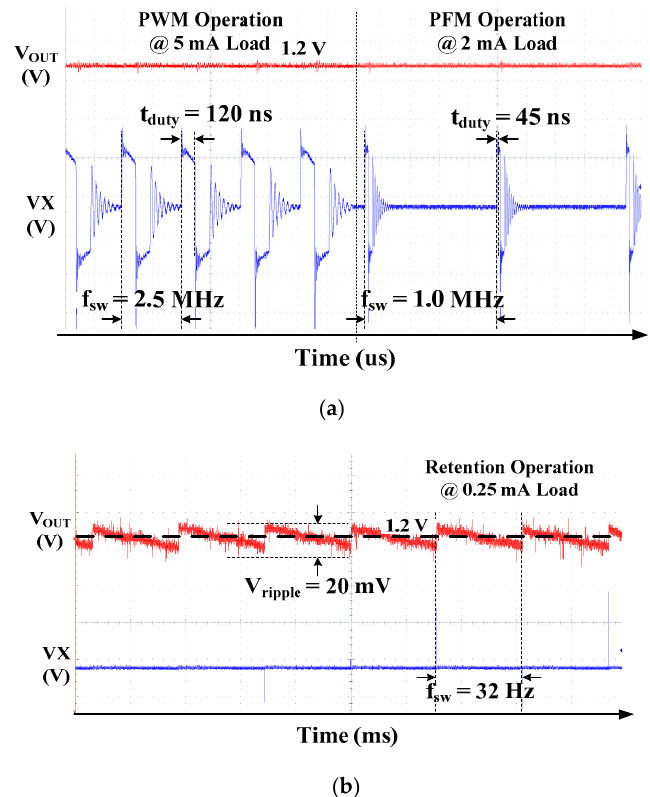
Figure 30. Measured waveforms of the triple-mode DC-DC Converter in ( a ) PWM/PFM mode and ( b ) retention mode.